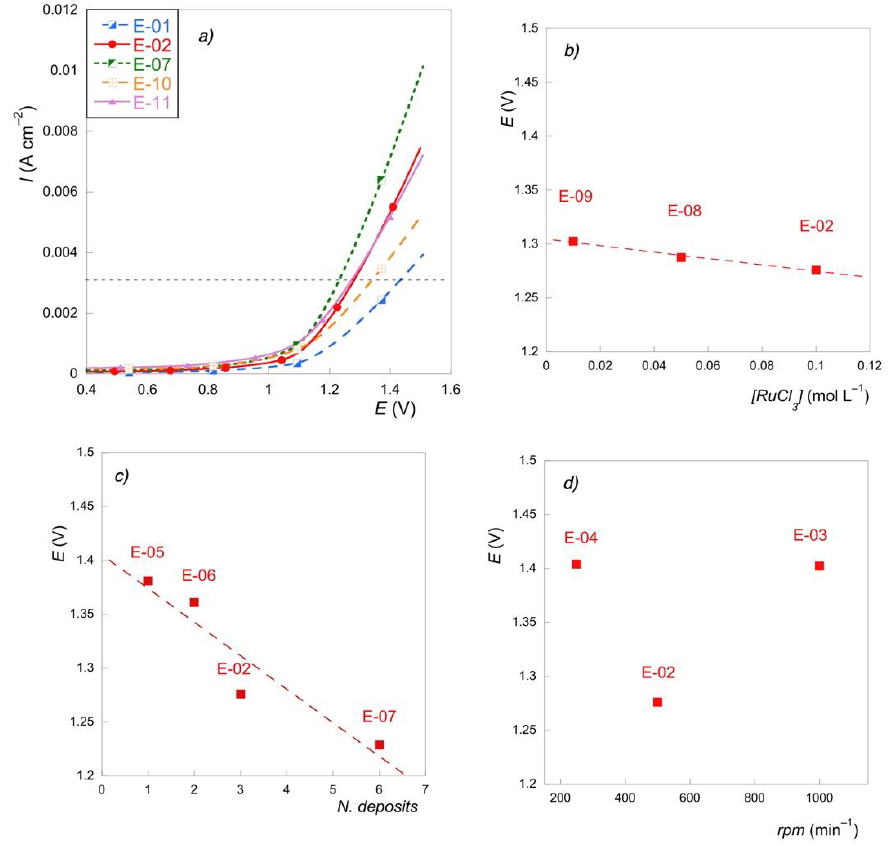
Figure 5. ( a ) LSV for some selected electrodes; ( b ) E(V) @ 3 mA∙cm –1 vs. precursor concentration; ( c ) E(V) @ 3 mA∙cm –1 vs. number of deposits; ( d ) E(V) @ 3 mA∙cm –1 vs. spin rate.